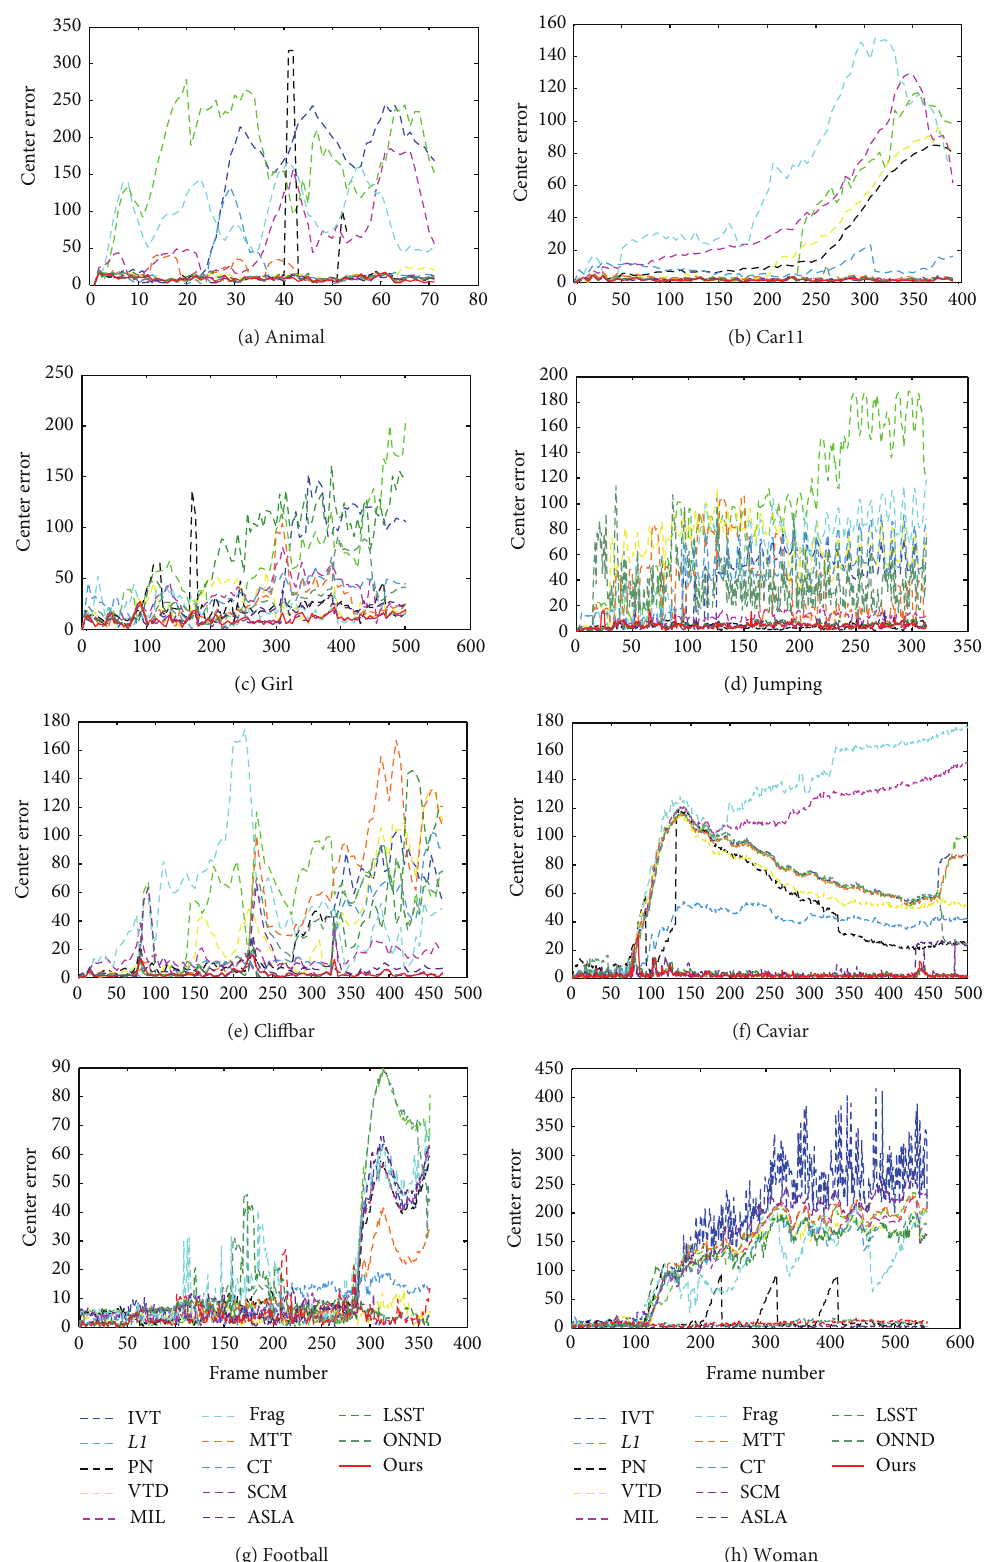
Figure 1: Central-pixel error. This figure shows central-pixel error for ten tested video clips. Our algorithm is compared with ten state-of- the-art